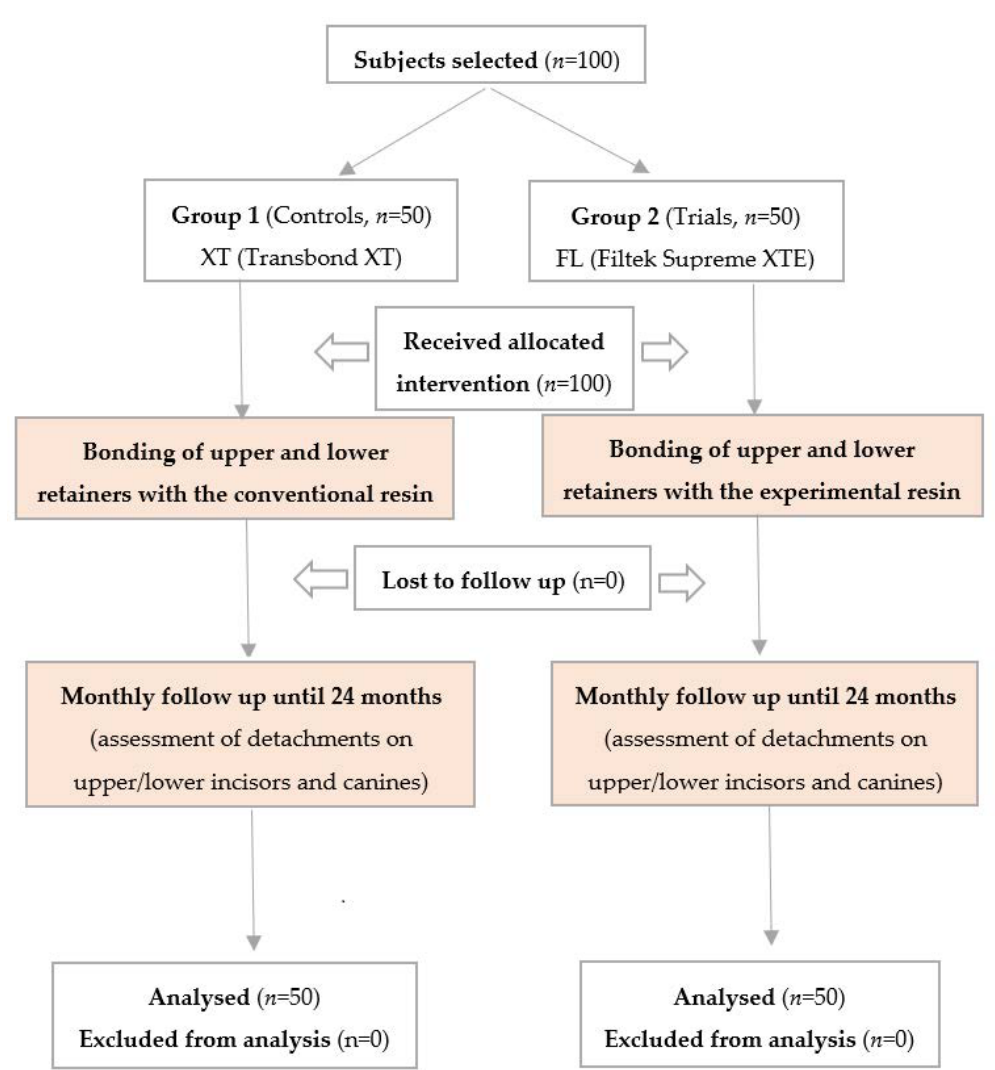
Figure 4. Flow chart showing participants and the protocol used in this